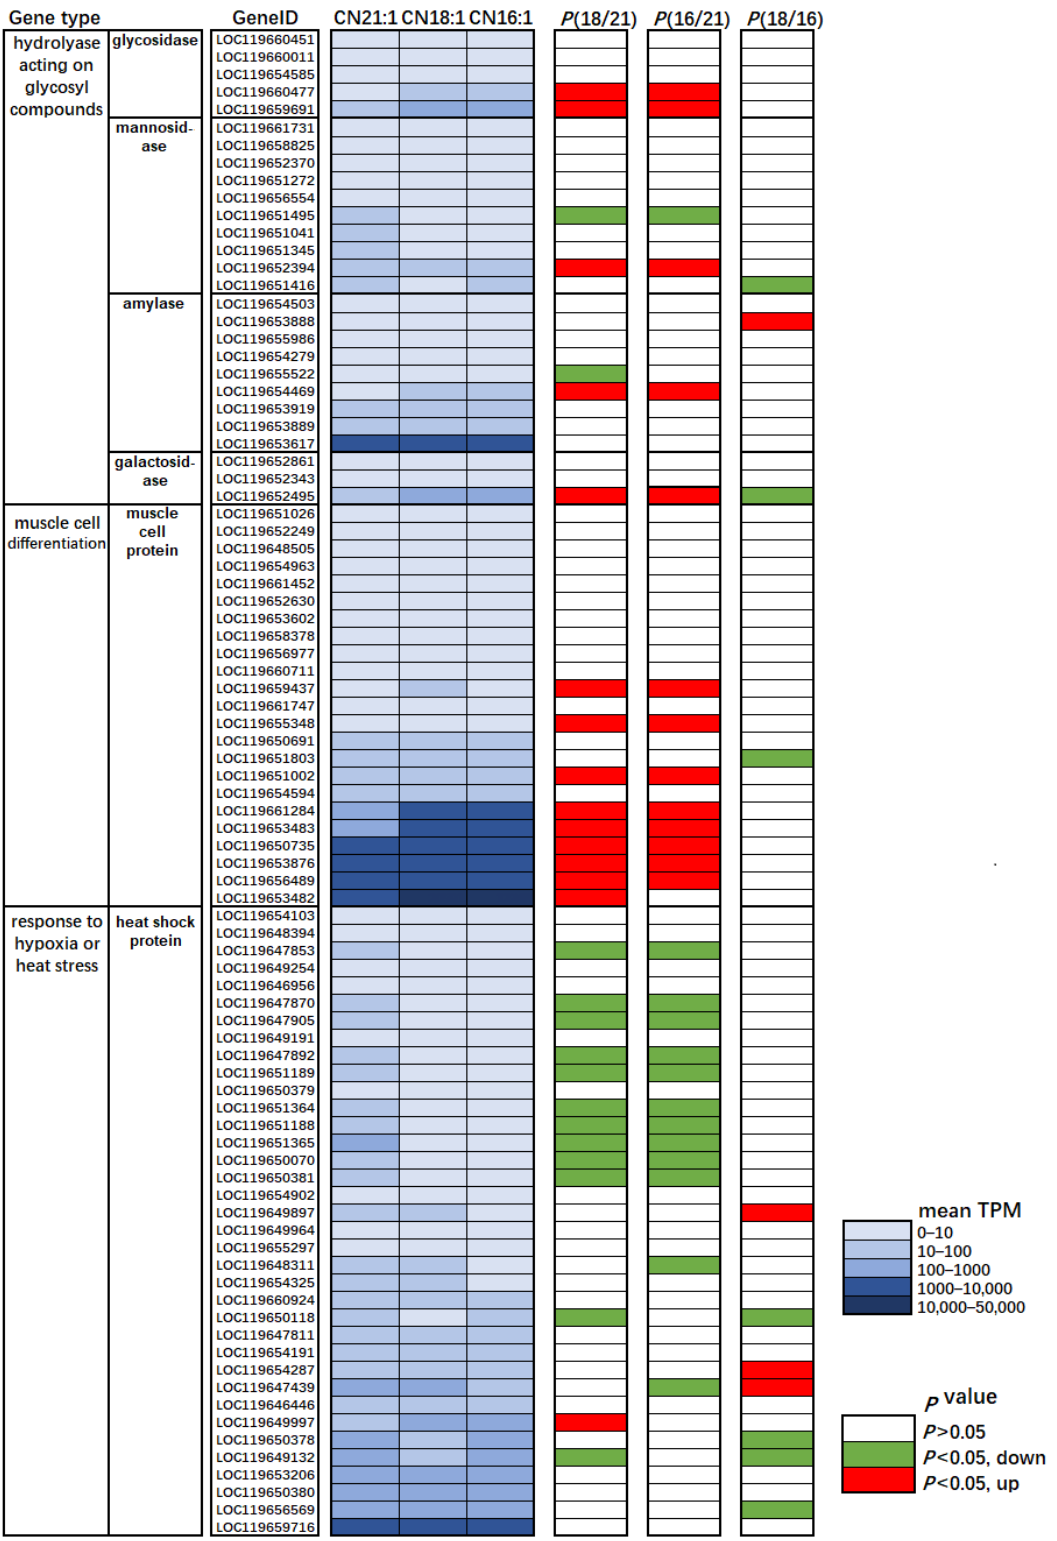
Figure 8. The transcriptome profiling of glycosyl hydrolase, muscle protein, and heat shock protein gene families among larvae reared in the C/N 21:1, 18:1, and 16:1. The average TPMs (n = 3) are displayed in blue color scale, and the statistical differences of C/N 18:1 vs. 21:1, C/N 16:1 vs. 21:1, and C/N 18:1 vs. 16:1 are shown in the red (up-regulated) or green (down-regulated) color.